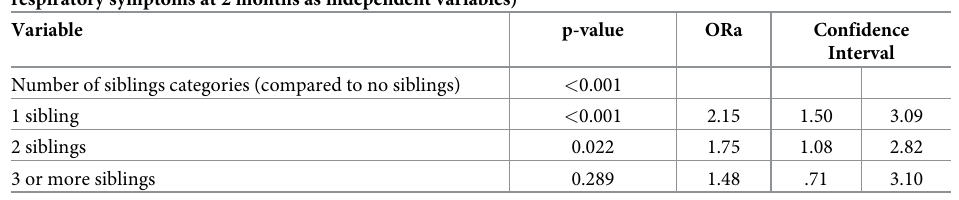
Table 5. Multivariable